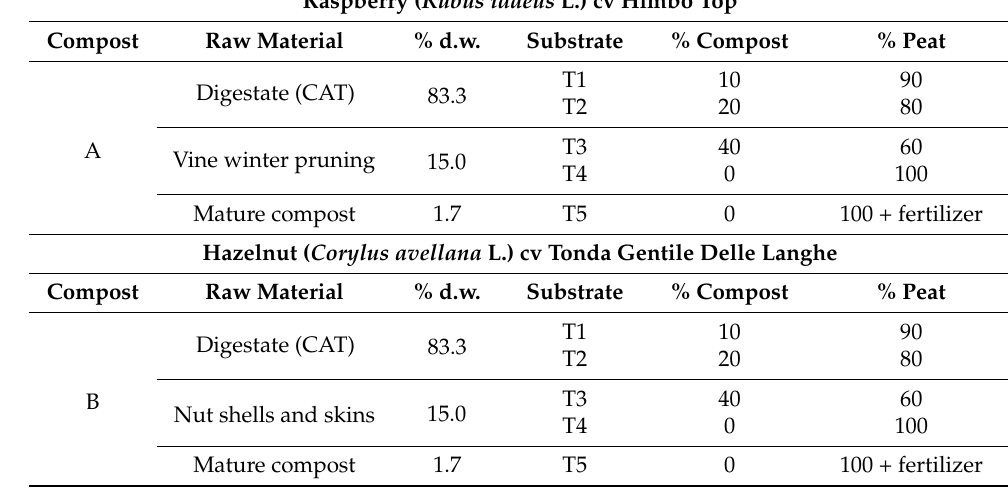
Table 1. Composition of the two composts produced and of the five experimental substrates for each species.